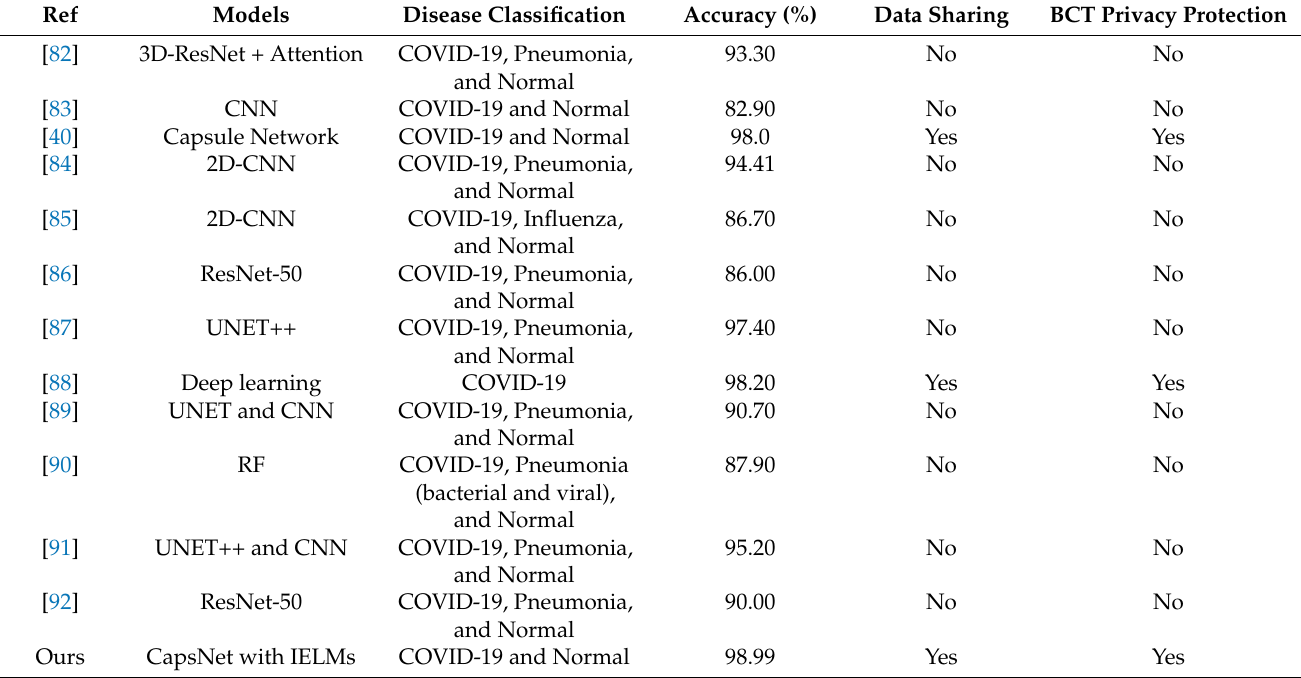
Table 6. Performance comparison of the proposed model with recent